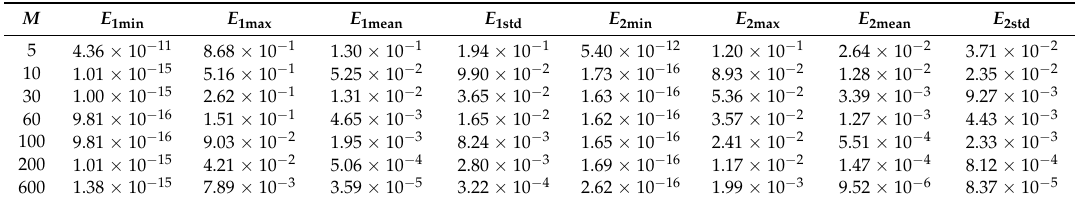
Table 3. Statistical results of errors in the Voigt waveshape numerically generated by Gauss-Hermite quadrature with different numbers of sample points.